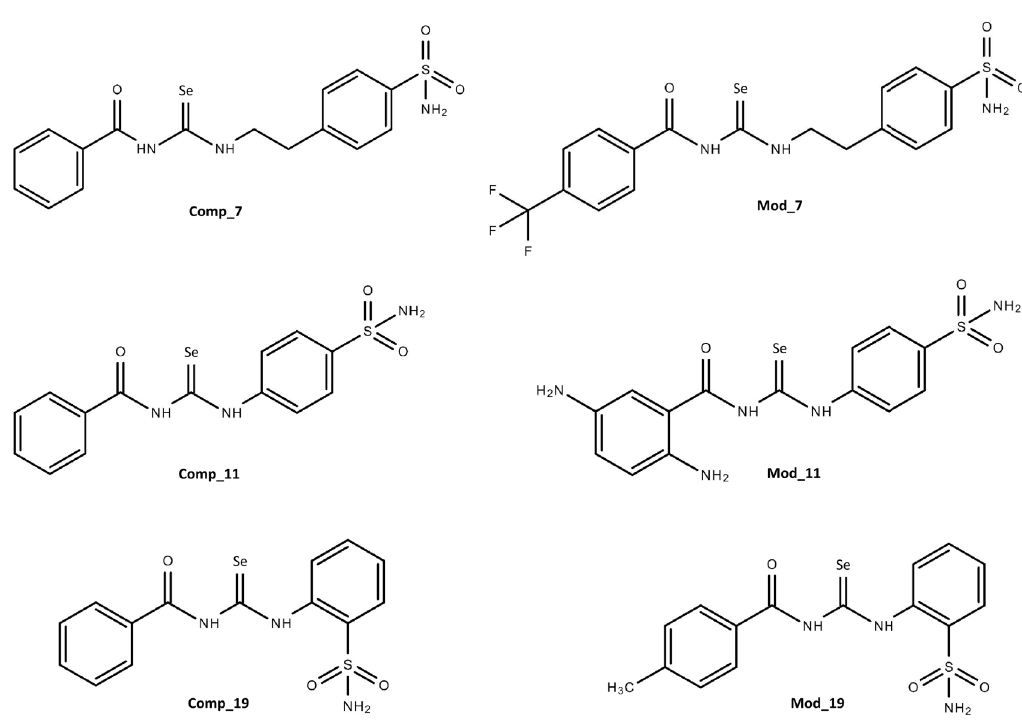
FIGURE 6 - Original and modified compounds used to explore the impact of discriminative GRINDs on CAs selectivity . Original and modified structures are indicated by Comp and Mod tags, respectively.